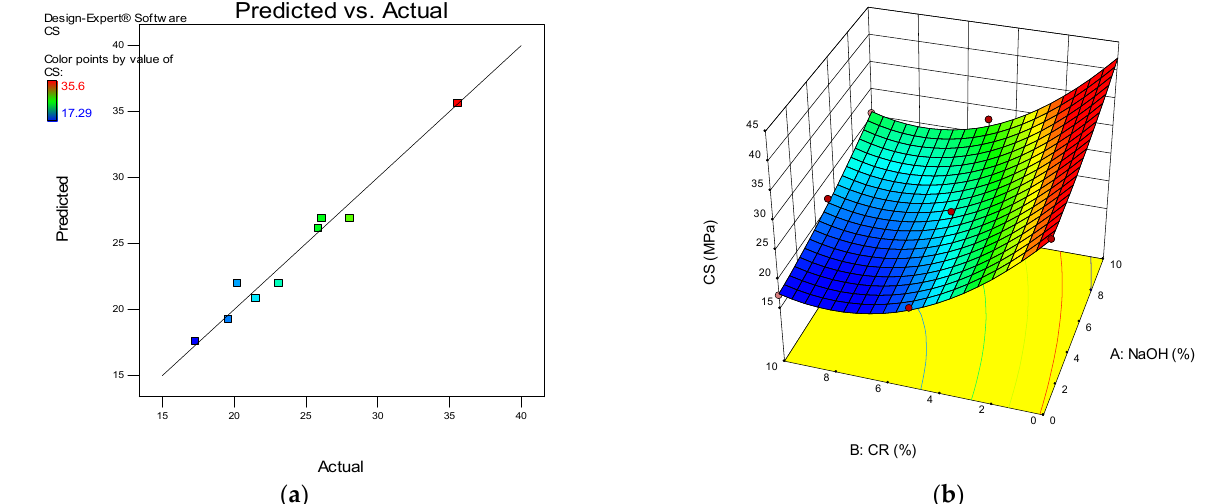
Figure 12. ( a ) Predicted vs. actual plot for compressive strength (CS). ( b ) 3D response surface diagram for CS.